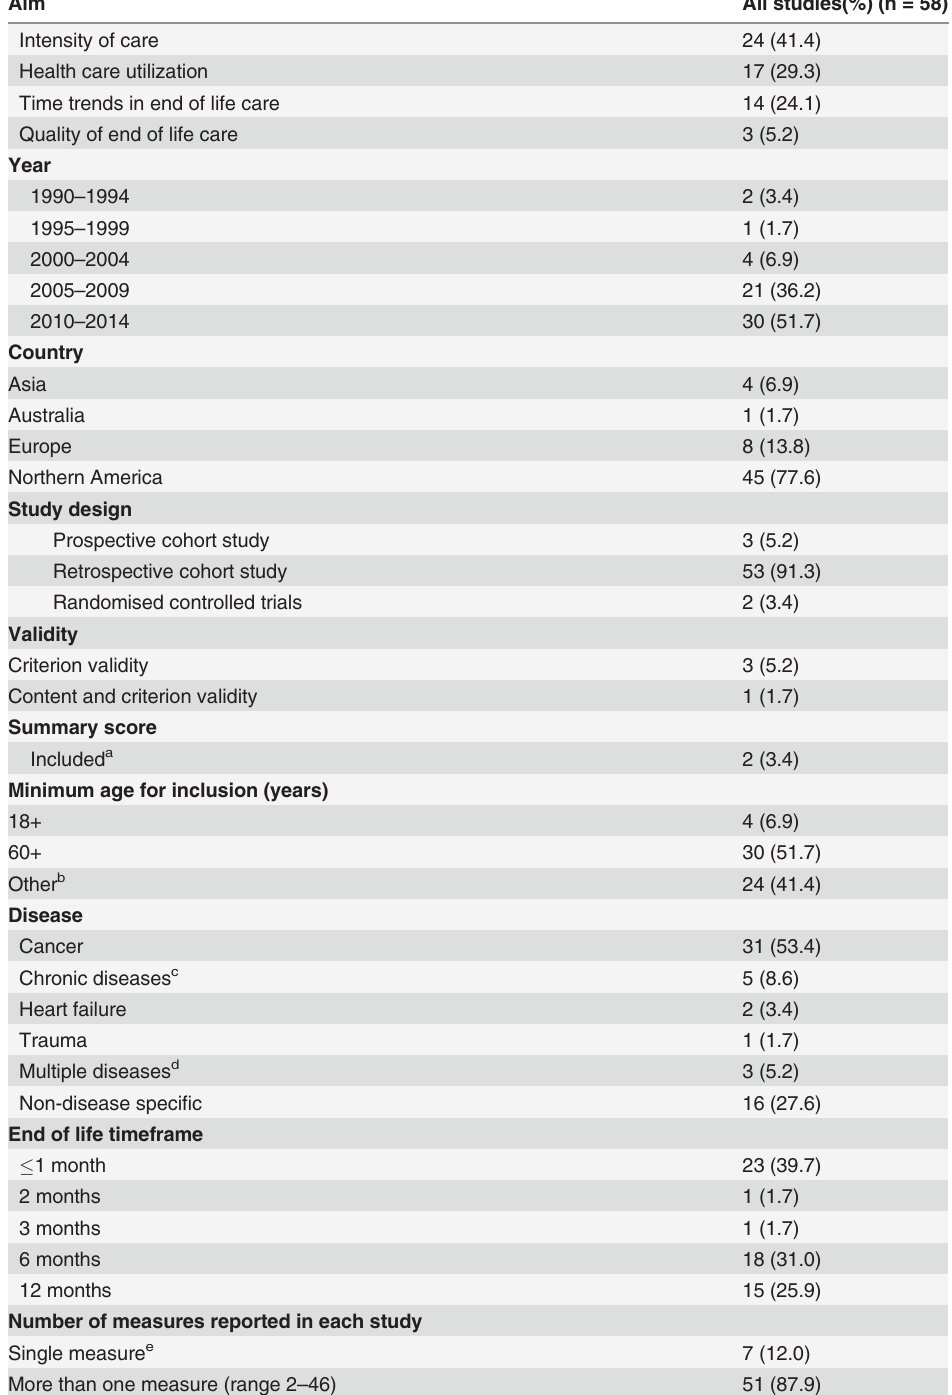
Table 1. Characteristics of included